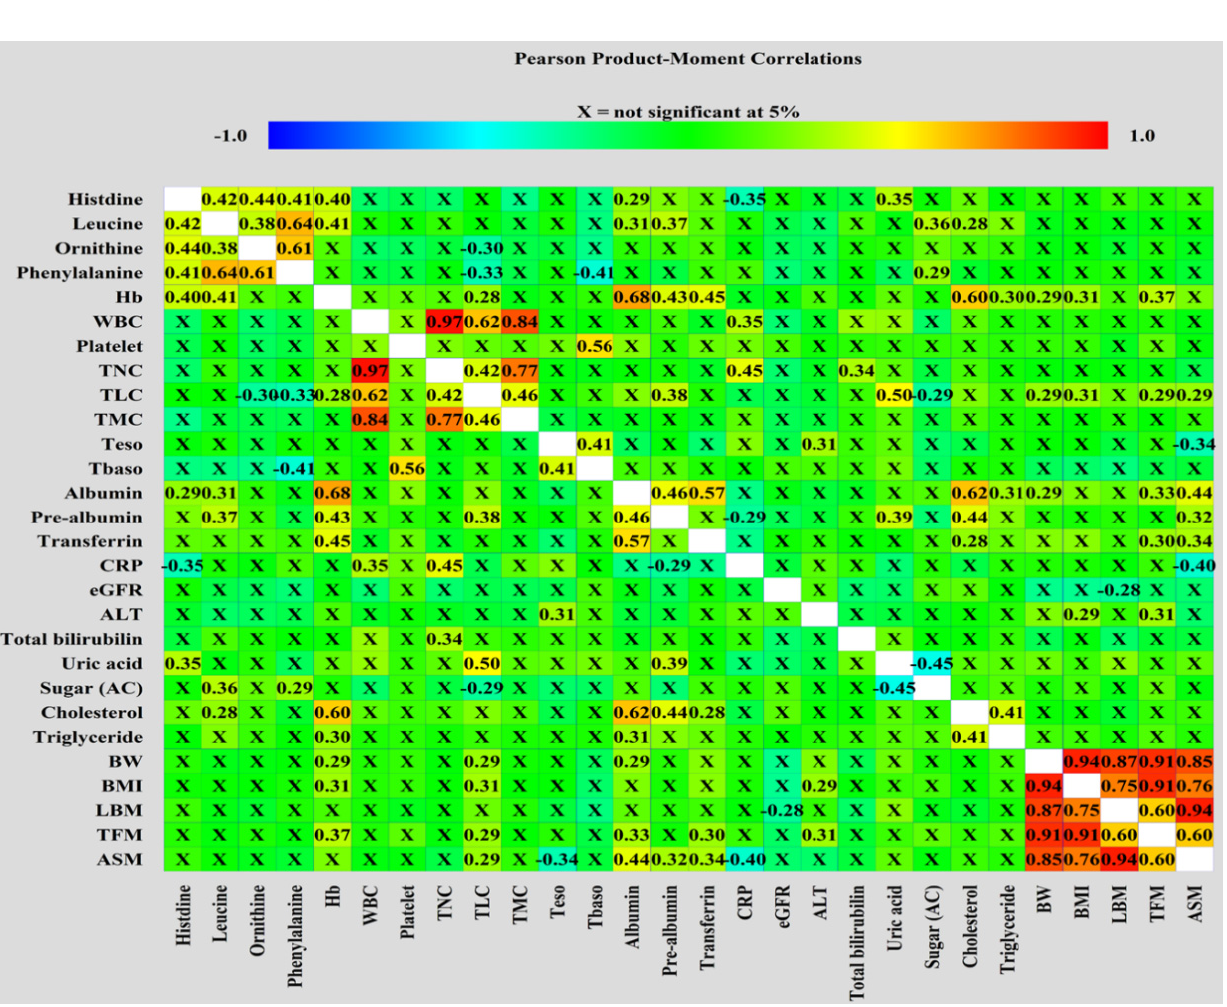
Figure 1. Correlation matrices used to visualize the correlations of the pretreatment levels of metab- olites, biochemical and anthropometric factors, NIBs, and DXA-derived parameters were obtained using Pearson correlation coefficient.